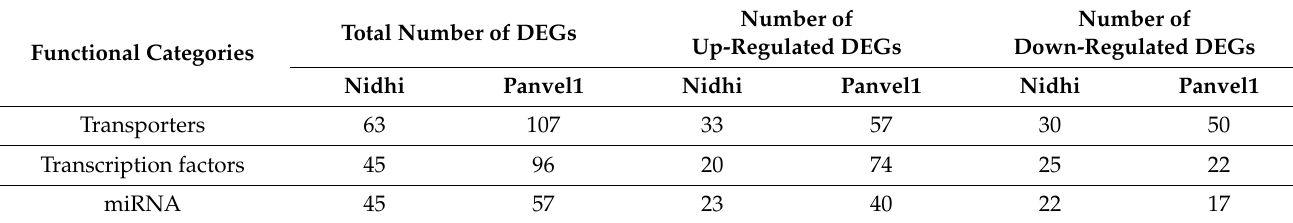
Table 1. Details of the DEGs associated with various functional